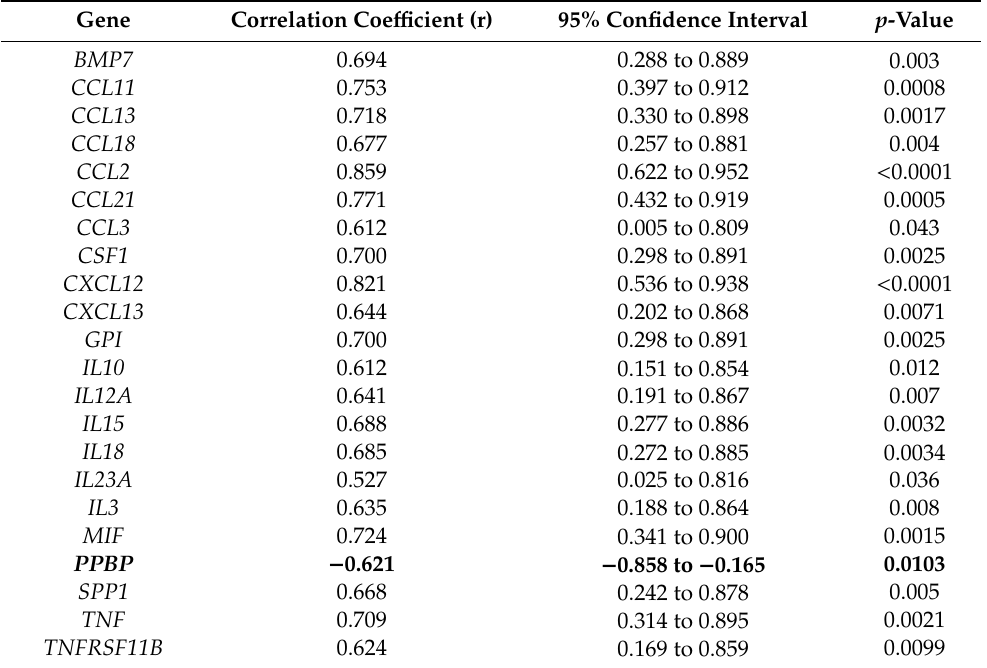
Table 1. Correlation between the fold changes in mRNA levels for the indicated cytokines and the corresponding EBOV viremia in patients from the fatal group during the late phase of the infection. Only cytokines with correlation coe ffi cient ( r ) > 0.600 and p < 0.05 are shown. The only negative correlation is evidenced in bold